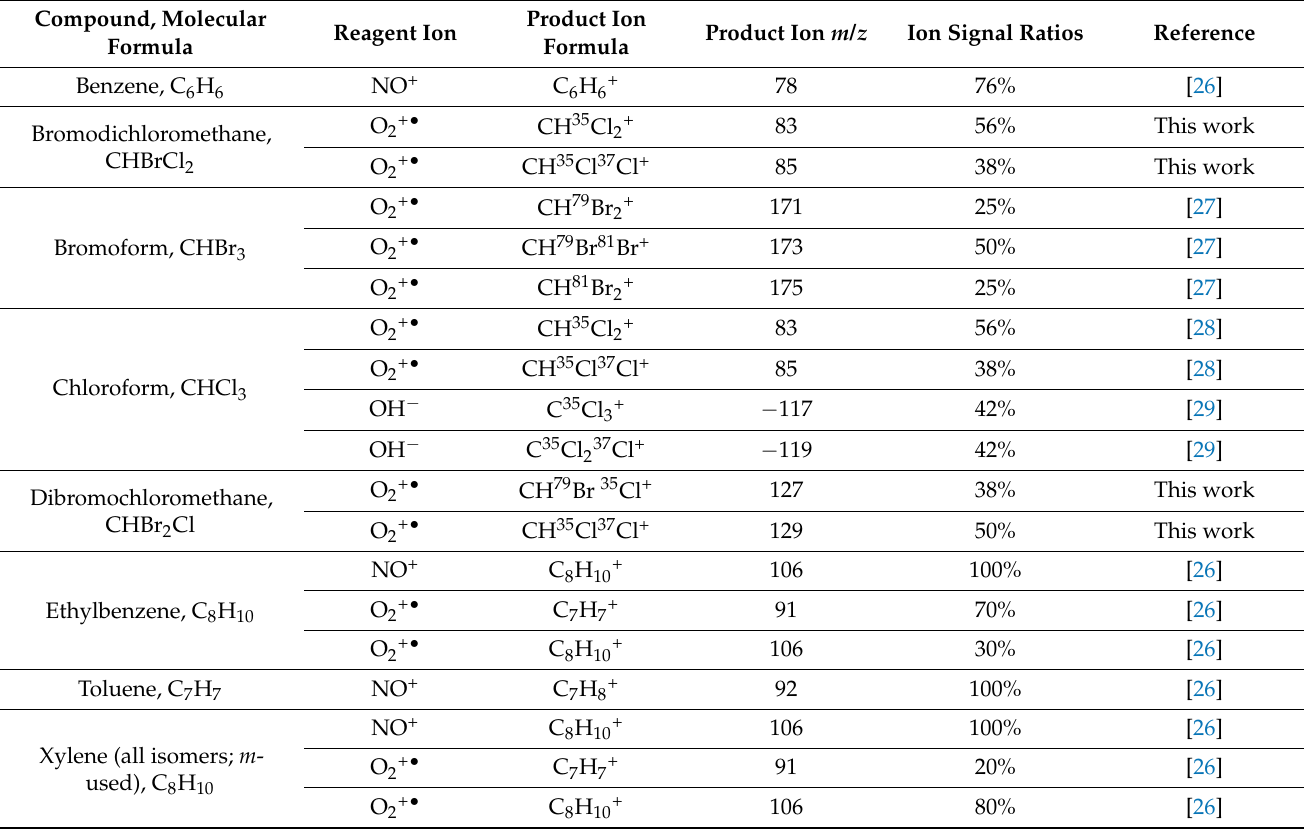
Table 2. Reagent ion-product ion pairs (product ions identified by mass-to charge ratios) used to quantify target compounds, with branching ratio (as a percentage). For simplicity, other unused ion products of each compound are not shown. See the text for resolution of bromodichloromethane from chloroform, and ethylbenzene from the sum of xylene